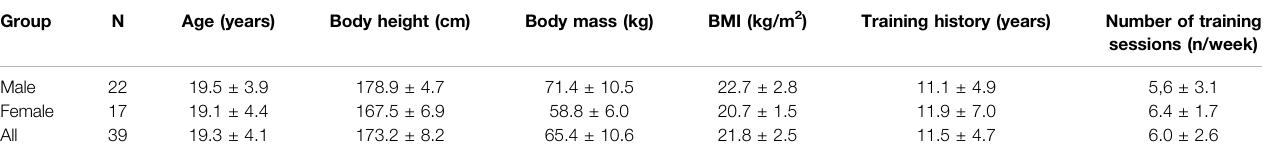
TABLE 1 | Characteristics of participants.